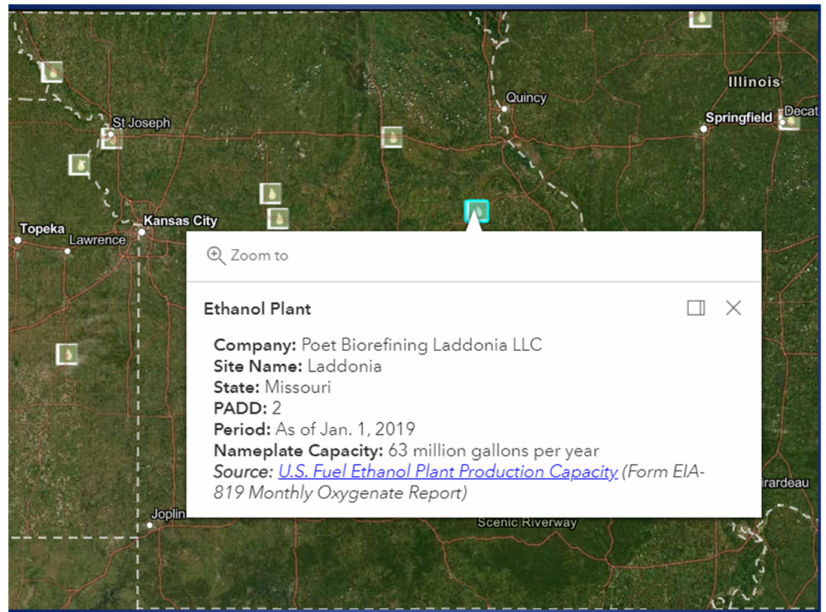
Figure 2. POET Bioethanol plant in Laddonia, Missouri (USA).